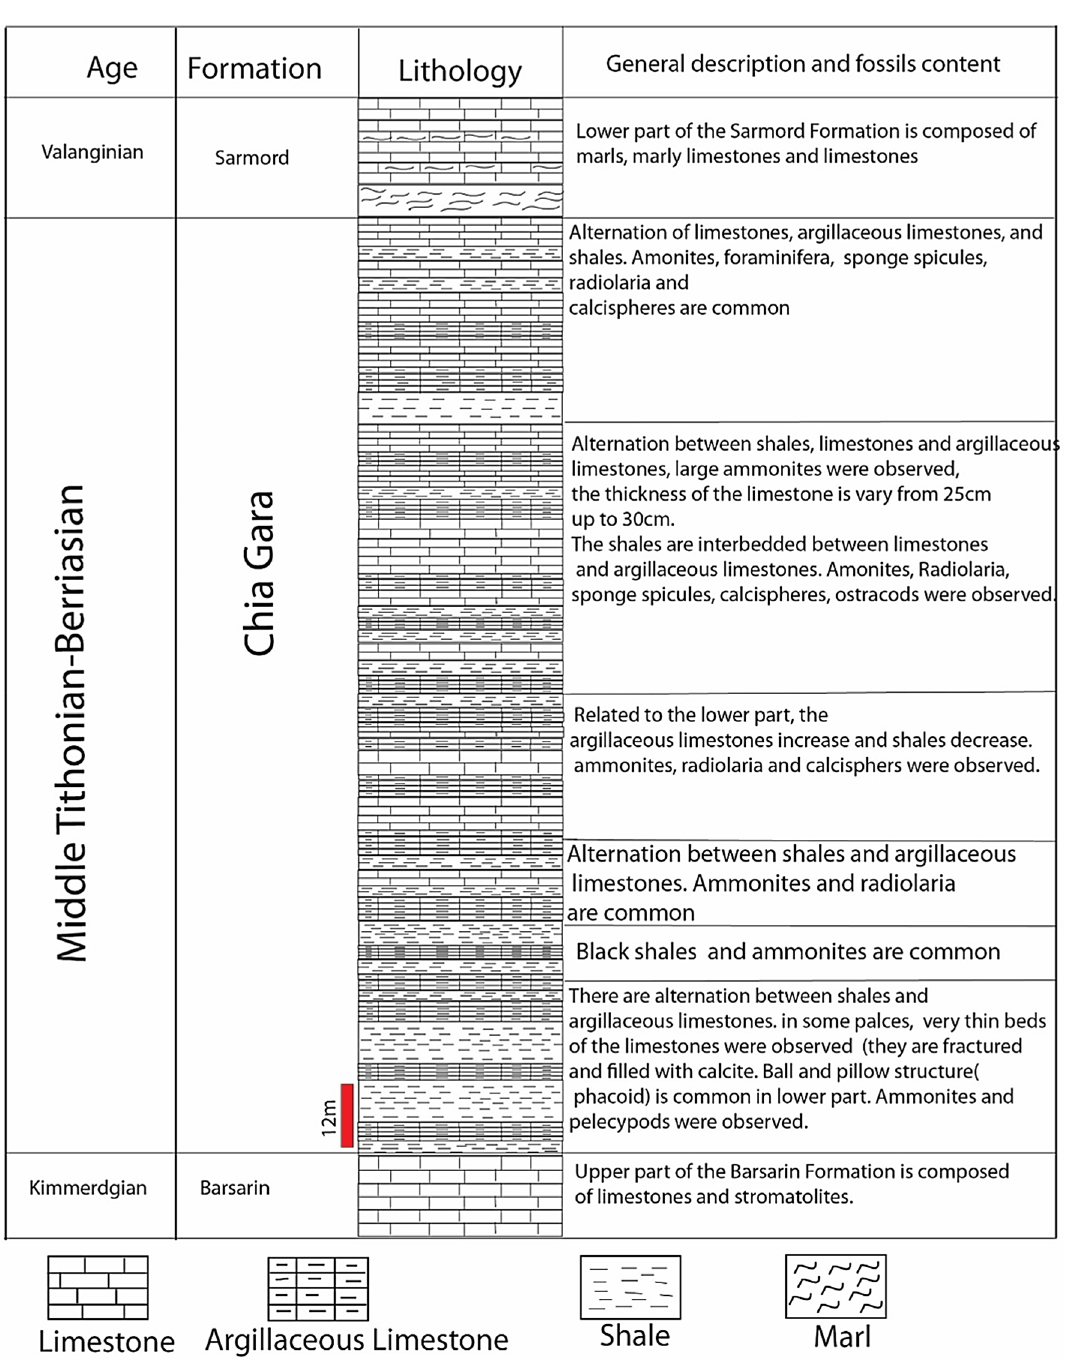
Fig. 3 Stratigraphic column of Chia Gara Formation in Barsarin Section, Erbil, Kurdistan